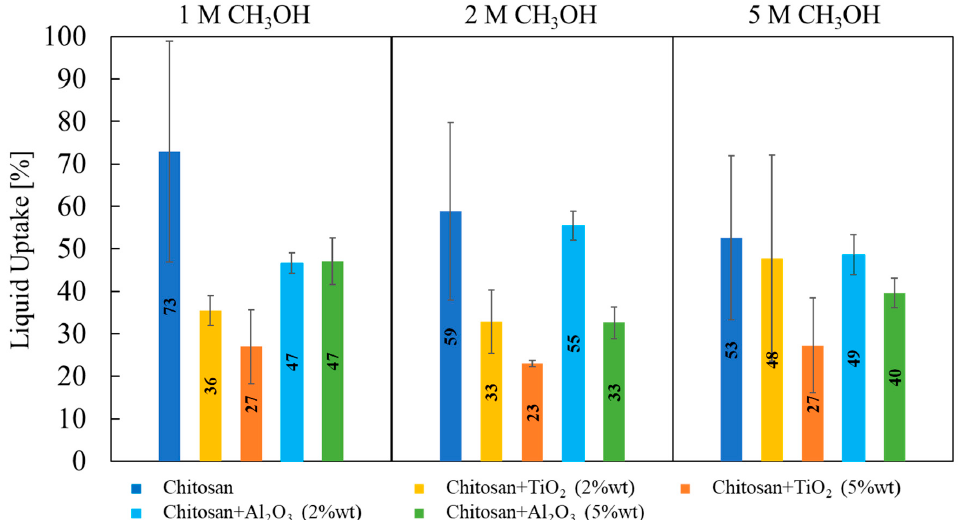
Figure 6. Liquid uptake values, estimated according to Equation (2), as a function of properties of synthesized membranes (filler) and methanol aqueous solution concentration.